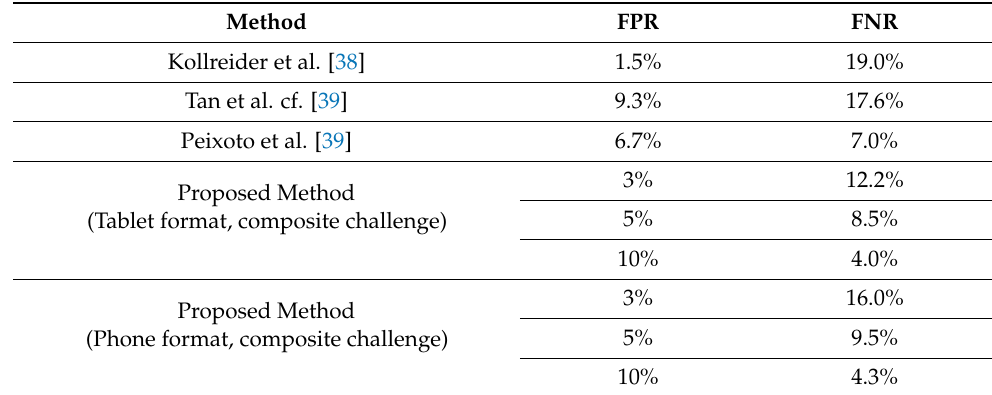
Table 7. FPR and FNR for various